Question: What caption would you write for this figure?
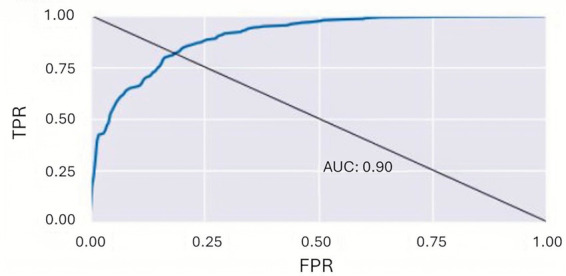
Answer: Strong AUC of 0.9 for discriminating 5 diopters based on the clinical threshold for vertical misalignment.